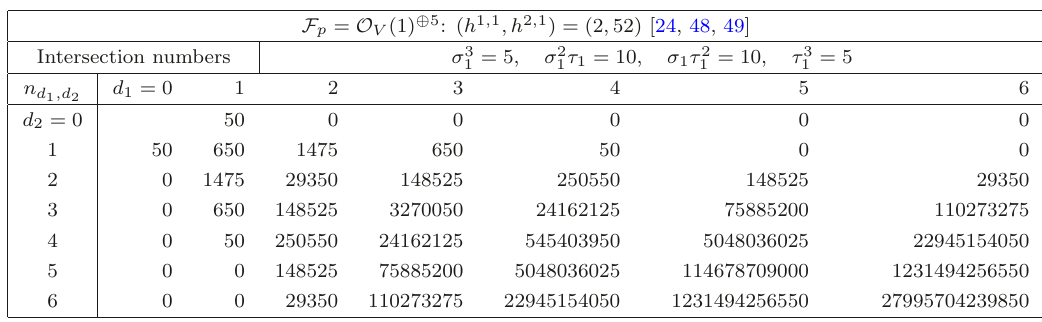
Table 4 . Genus-0 invariants of determinantal 3-folds in (2.22) with V = P 4